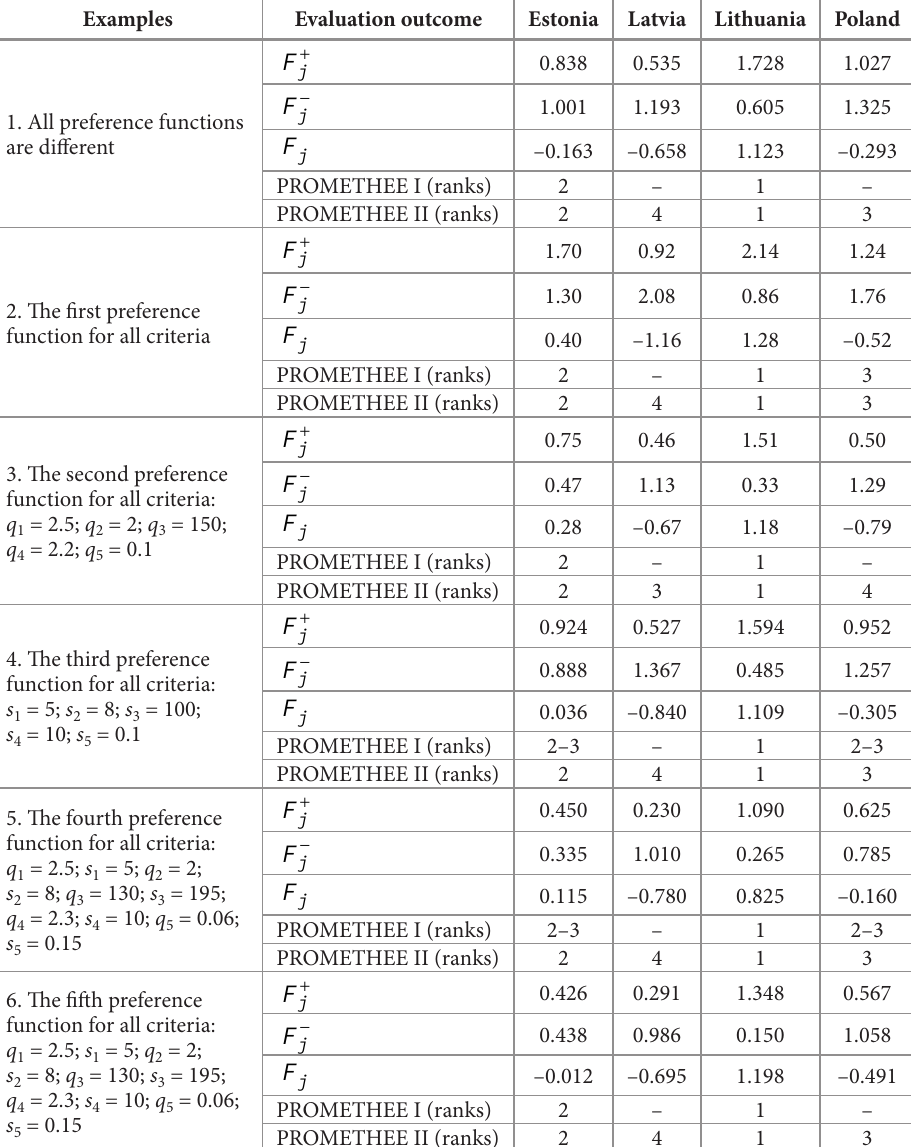
Table 3. Evaluations with different preference functions